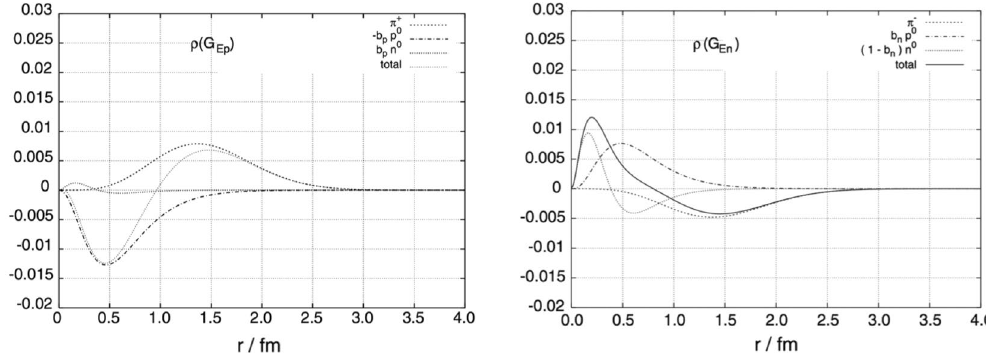
Figure 1. Shown as the dashed lines are the densities of nucleon charge contributed by the pion cloud, taken from ref. 36. Left panel: r 2 ρ ( r ) for the electric form factor of the proton. Right panel: r 2 ρ ( r ) for the electric form factor of the neutron.